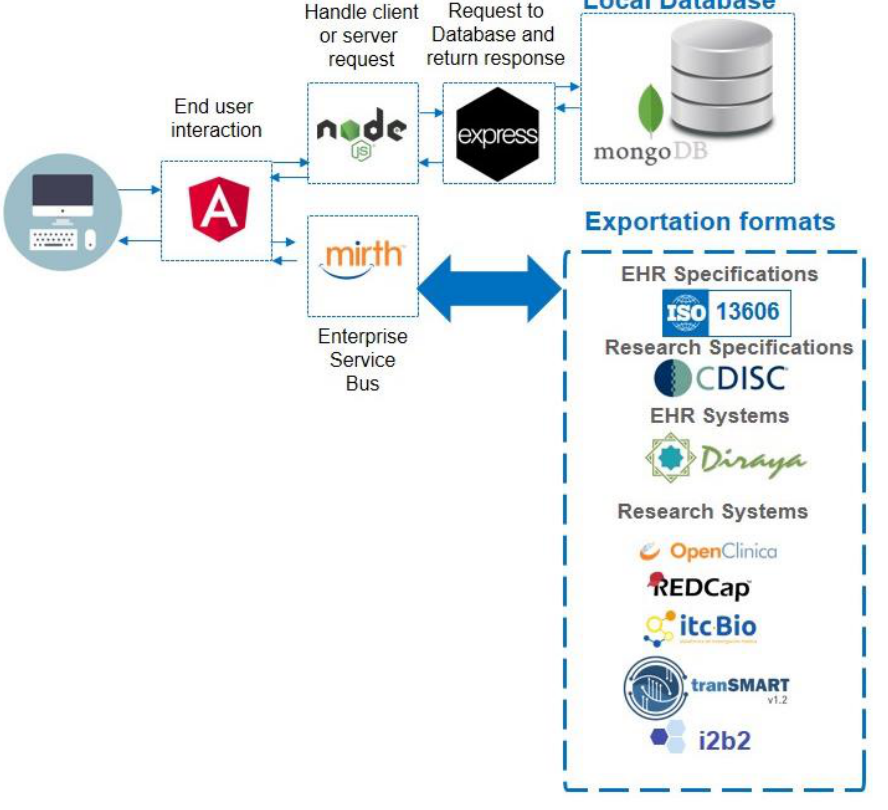
Figure 1. MedicalForms system architecture, including multiple components for user interaction, handling request, local database and Enterprise Service Bus mappings to produce results compliant with interoperability specifications and relevant opensource systems.